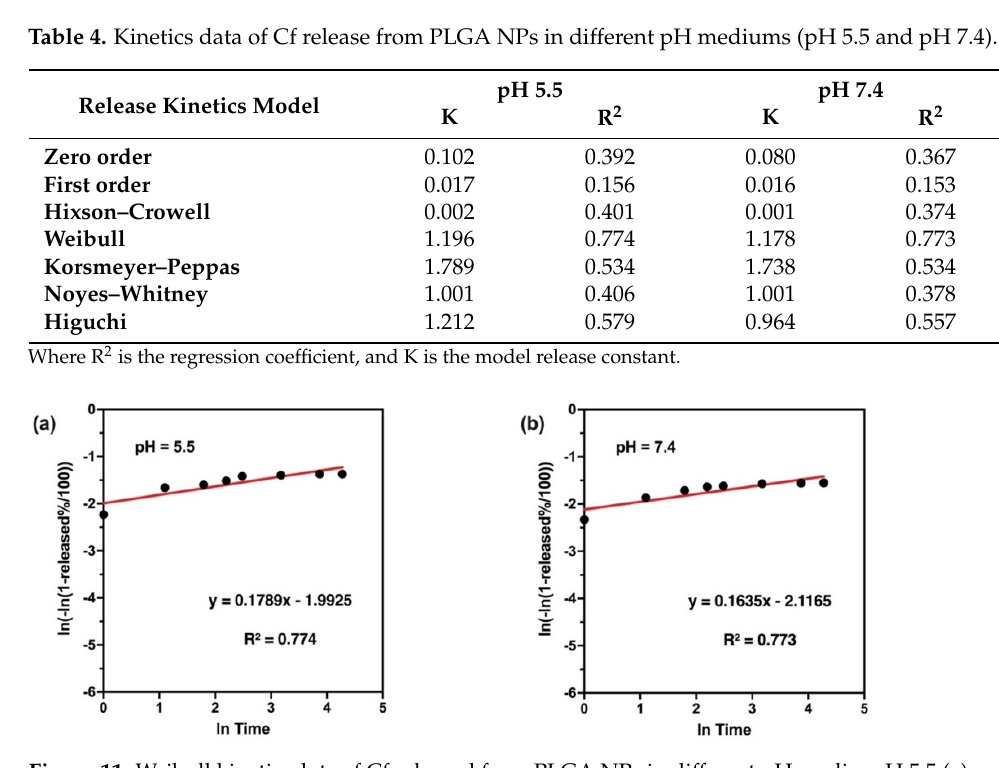
Figure 11. Weibull kinetic plots of Cf released from PLGA NPs in different pH media: pH 5.5 ( a ) and pH 7.4 ( b ).